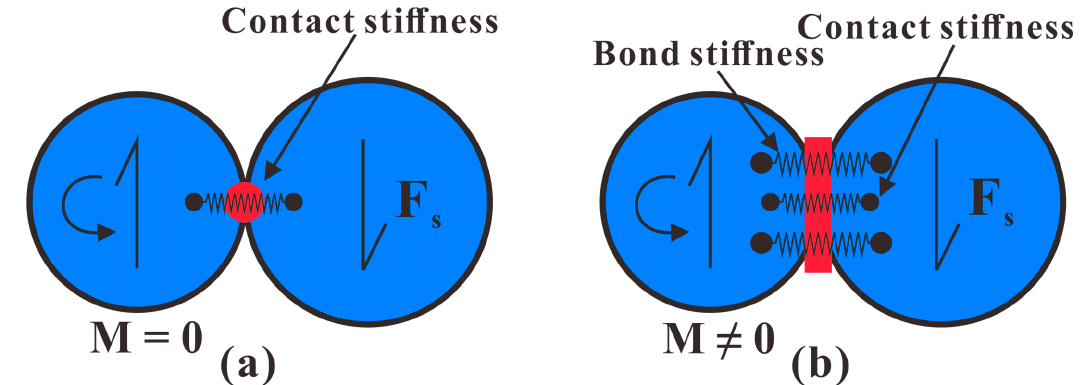
Figure 5. Bond models in PFC [17]. ( a ) Contact bond model; ( b ) Parallel bond model.